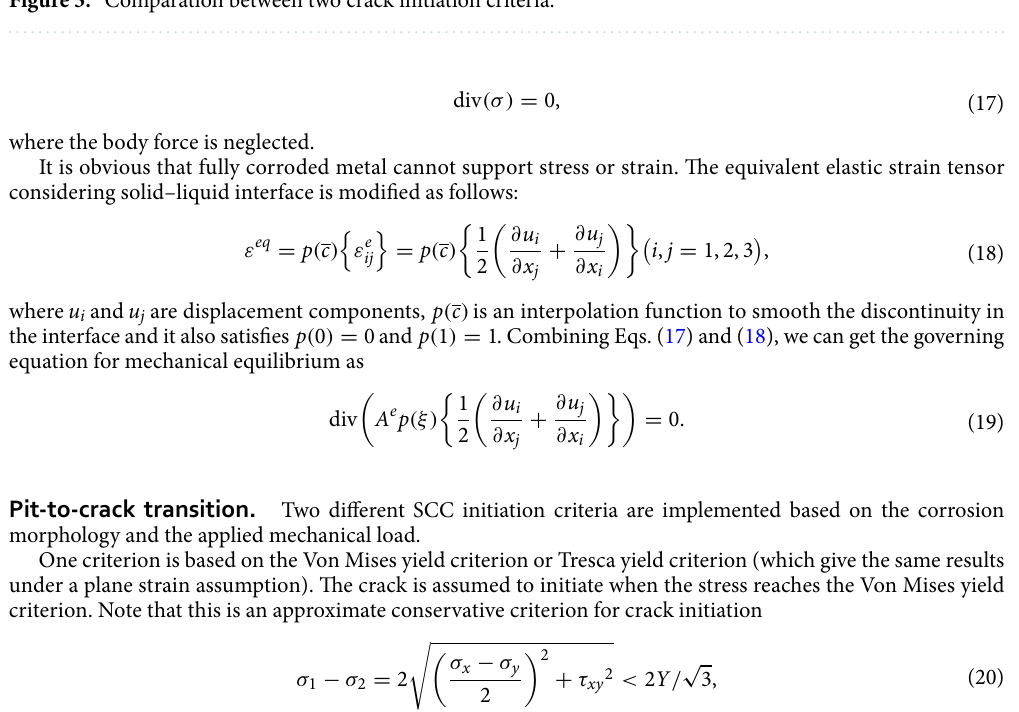
Figure 3. Comparation between two crack initiation